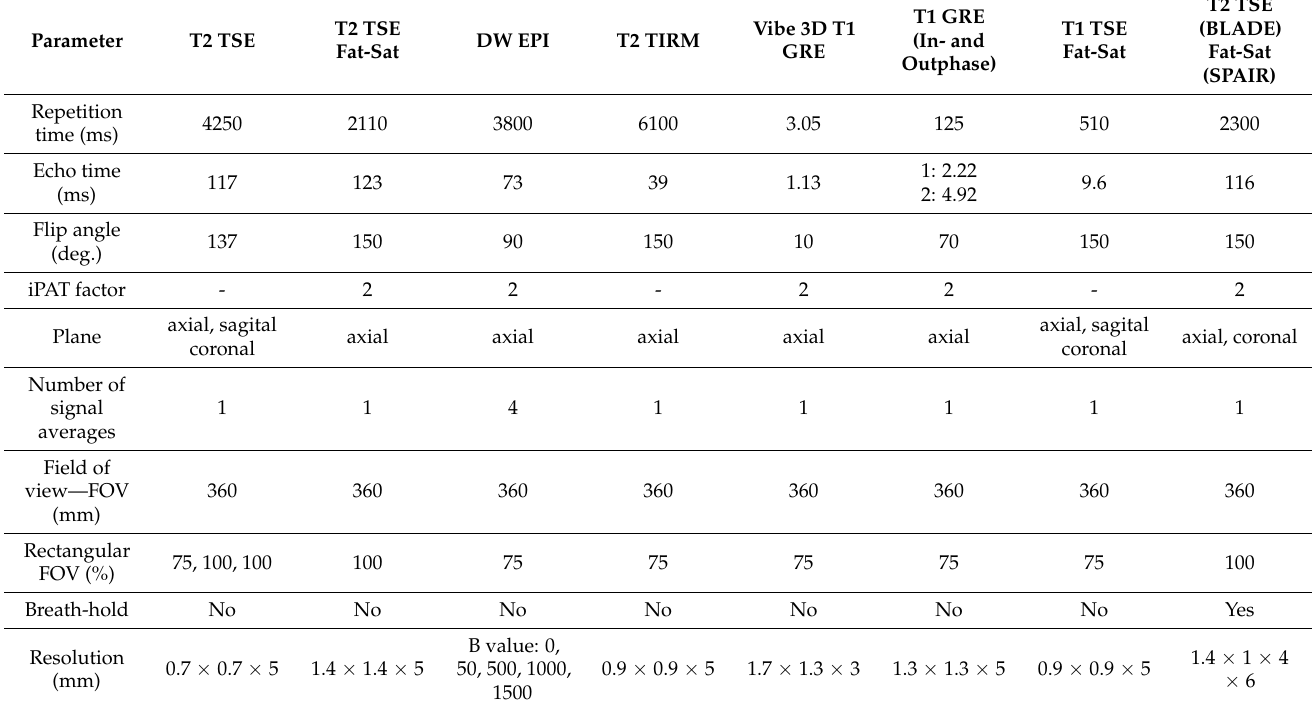
Table 2. MR study